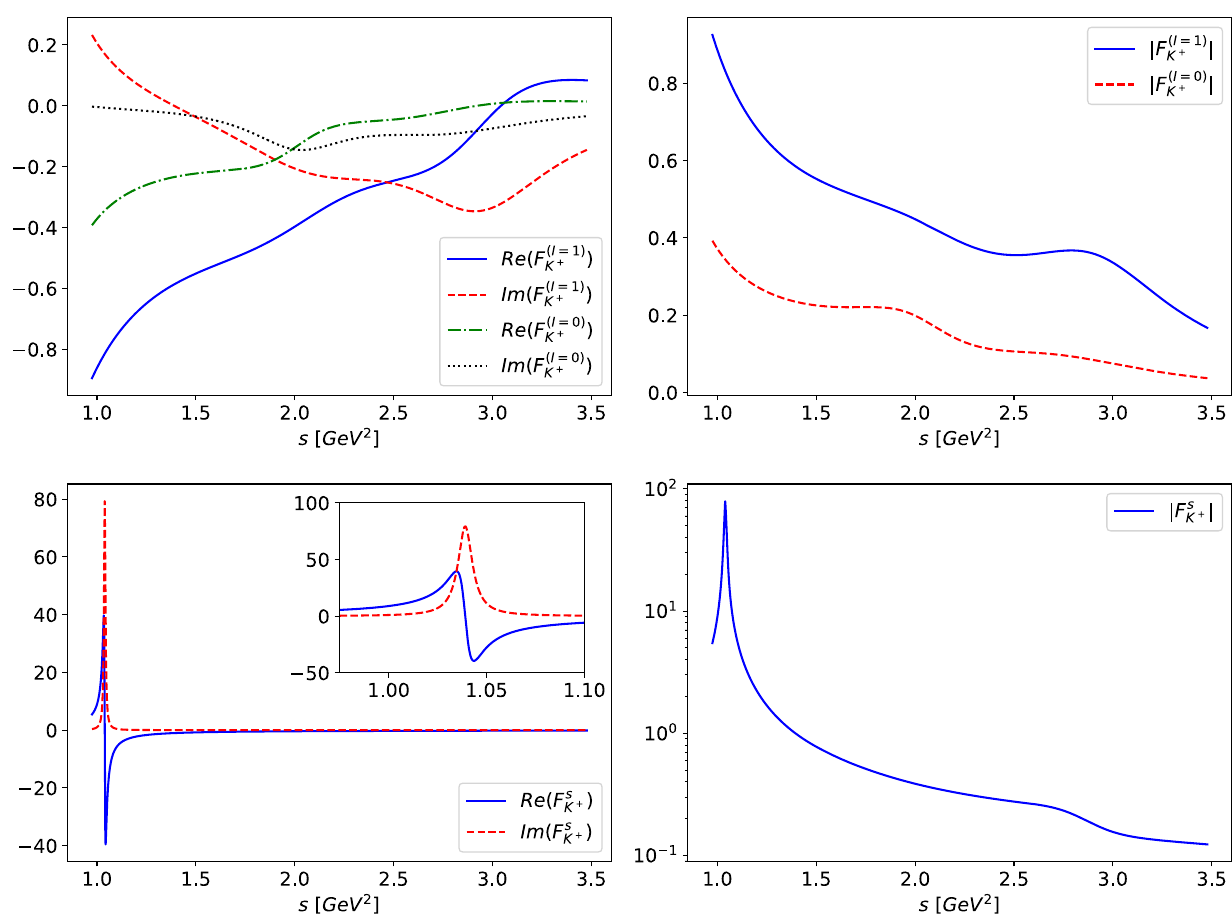
Fig. 16 The real and imaginary parts of the electromagnetic kaon form factors (B8) (left) as well as their absolute values (right) as a function of s . The upper (lower) plots show F ( I = 1 , 0 ) ( F s ) K + K + Fig. 17 The real and imaginary − part (left) of the f K π + form factor (B10) as well as the absolute value (right) versus s in the two resonance models as well as in the dispersive description. The form factor is extracted from τ − → ν τ K s π − decays [13]. For ¯ K 0 π 0